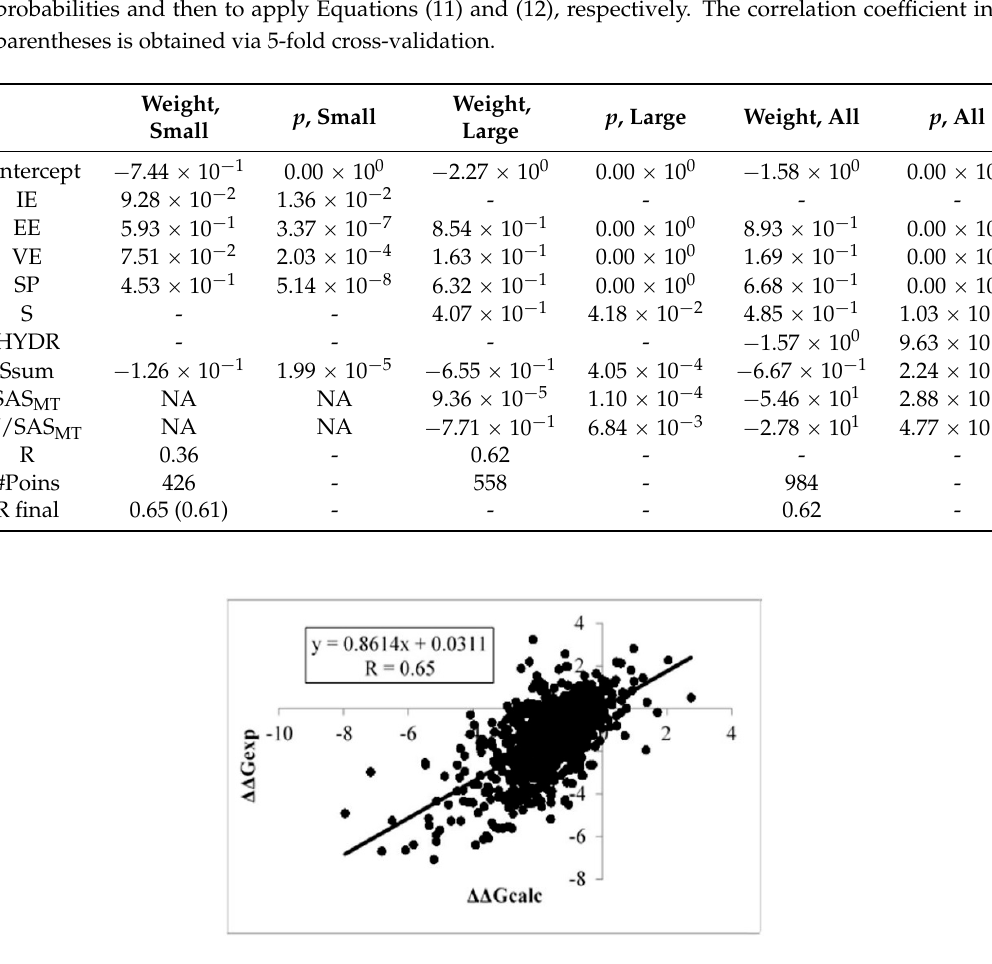
Figure 3. Correlation between experimental data and values calculated with the Single Amino Acid Folding free Energy Changes (SAAFEC) approach of the change in folding free energy due to single point amino acid mutations.